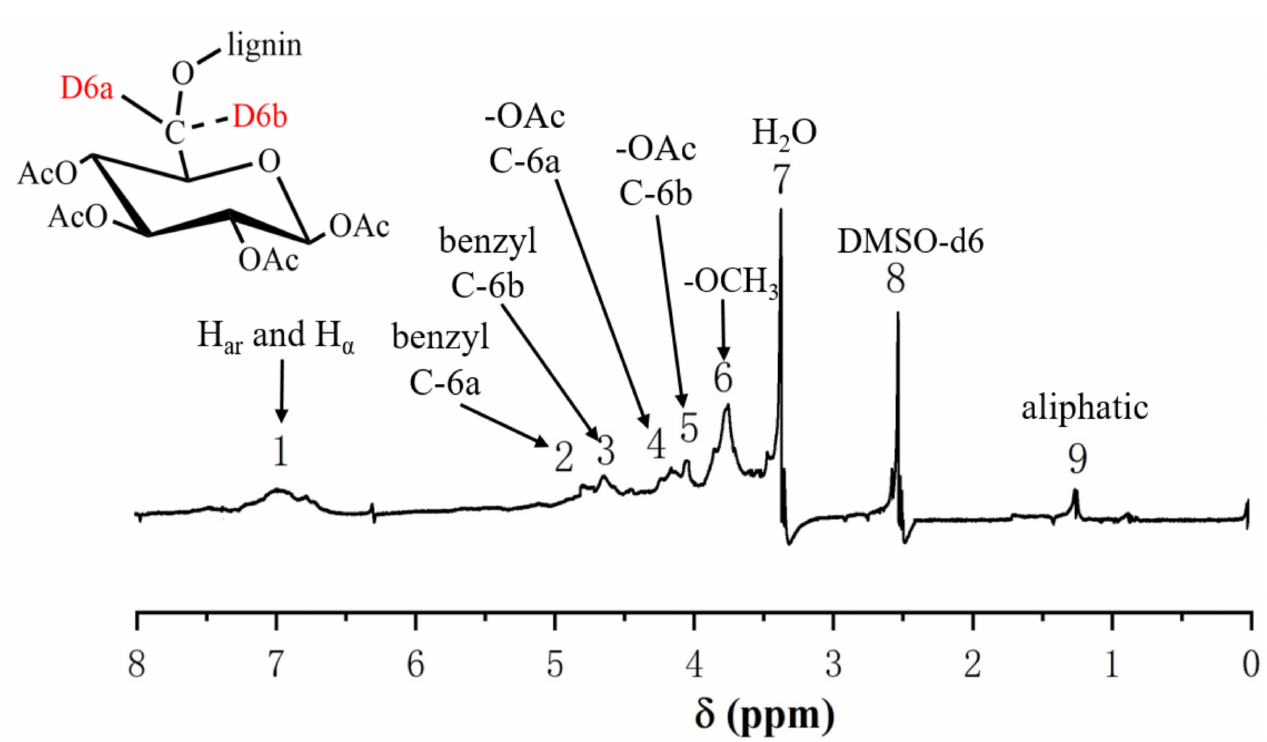
Figure 5. 1 H-NMR differential spectrum of Ac-En-GL obtained from ginkgo CW-DHP by subtracting the spectrum of Ac- En-GL-[ 13 C- 2 H] from the spectrum of